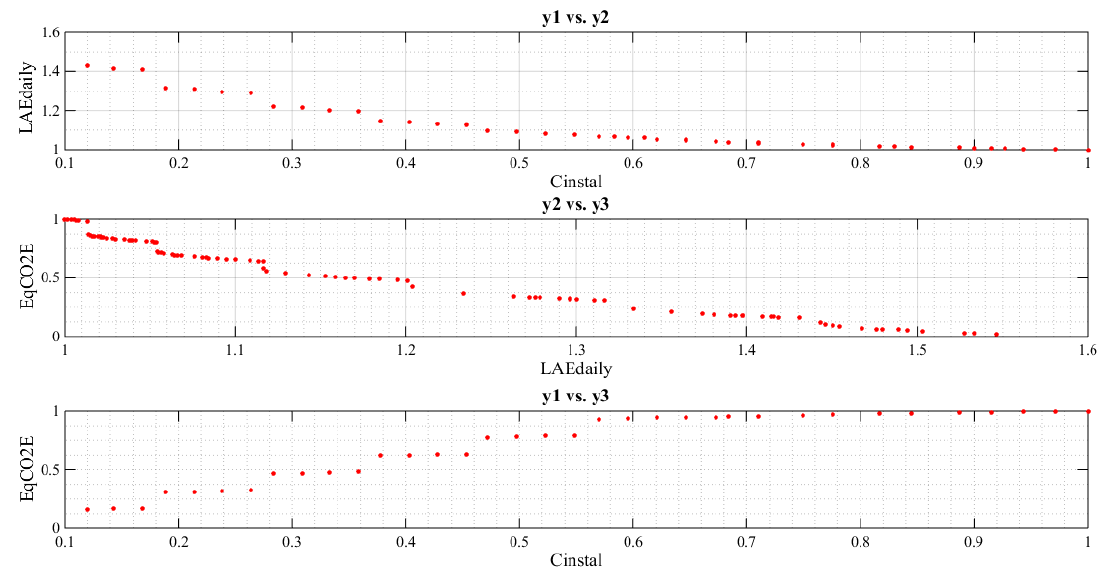
Figure 3. Three-dimensional plot of Pareto frontier—case-study I.